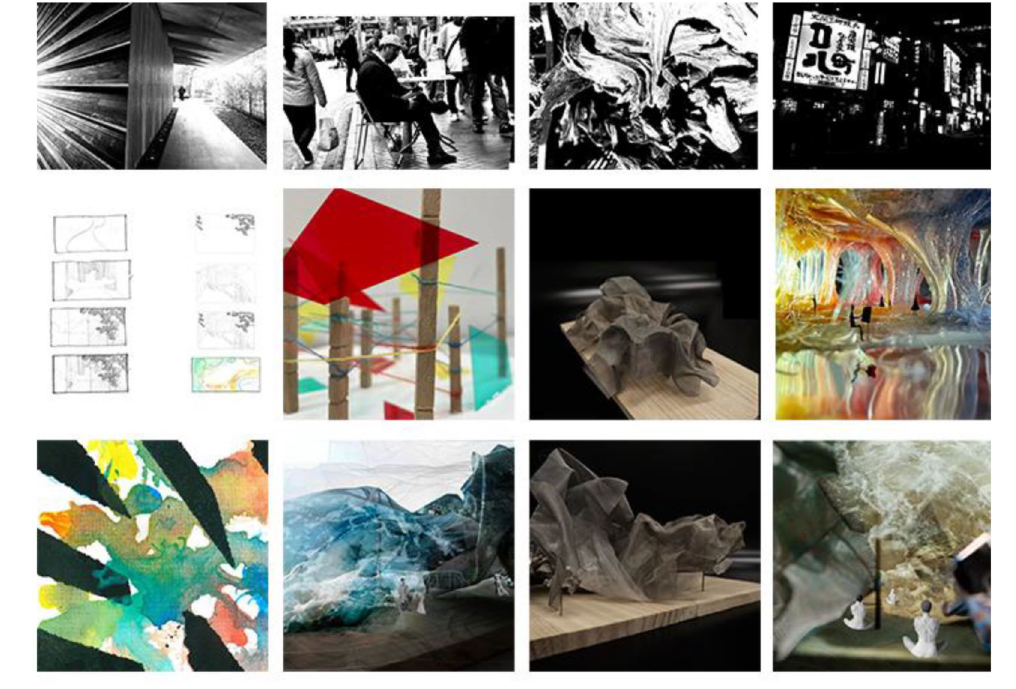
Figure 8. The reassembled design strategy in blended learning: experiencing rupturing and assembling (Source: Simon Kay-Jones and Louise Janvier,